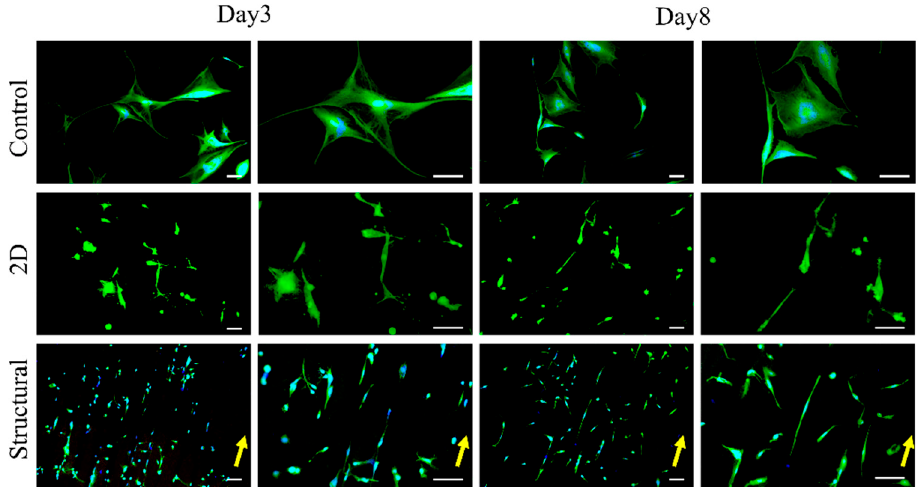
Figure 6. Morphologies of HDF cells on different scaffolds at days 3 and 8. Scale bar represents 100 µm at different magnifications. The yellow arrow indicates the direction of the triangular prism pattern of the structural scaffold.